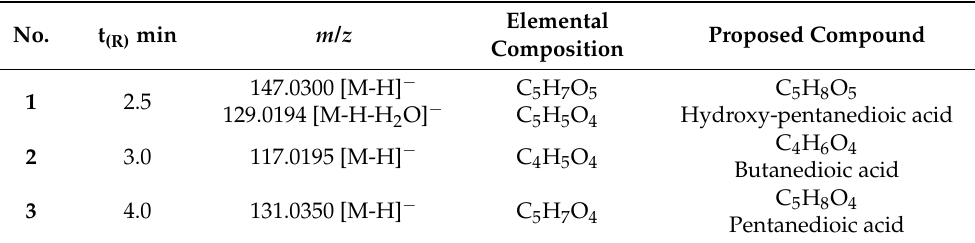
Figure 13. The effects of mannitol concentration on k obs (min − 1 ) and CPF removal efficiency (%) observed in solar light-assisted oxidative degradation of CPF catalyzed by Fe III -CS-GLA in aqueous solution. Experimental conditions: [CPF] 0 : 50 µ M, [Fe III ] 0 in Fe III -CS-GLA: 1.25 mM, [GLA] 0 in Fe III -CS-GLA: 90 mM, [H 2 O 2 ] 0 : 6 mM, [Mannitol]: 0–7 mM, volume of CPF solution: 250 mL, pH: 3, light intensity: 70,000–90,000 Lux, solar light irradiation time: 180 min. Table 2. Compounds detected by HPLC-ESI(-)-MS after solar light-assisted oxidative degradation of CPF in aqueous solution catalyzed by Fe III -CS-GLA in presence of H 2 O 2 . Elemental No. t (R) min m/z Proposed Compound Composition 147.0300 [M-H] − 129.0194 [M-H-H 2 O] − 117.0195 [M-H] − 131.0350 [M-H]